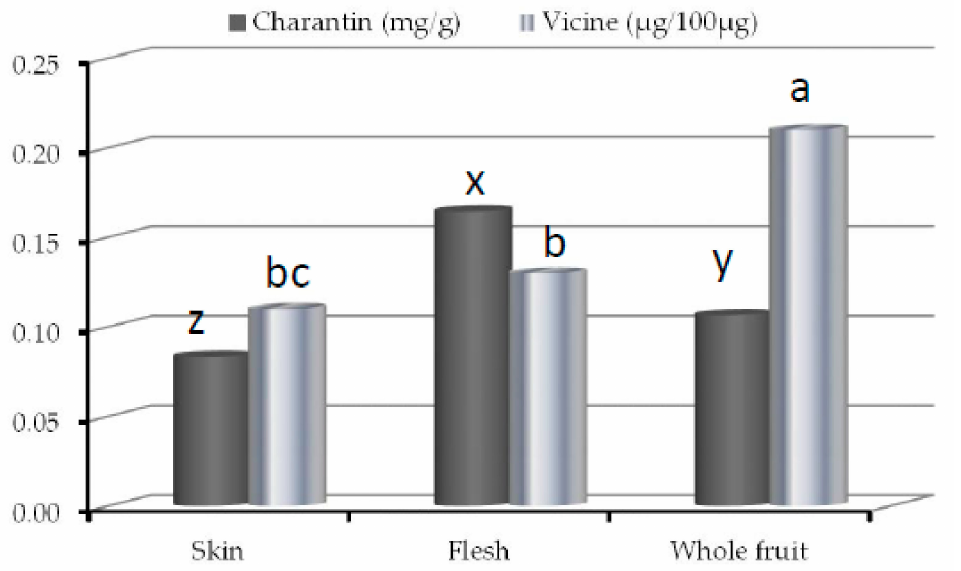
Figure 1. Charantin and vicine contents in skin, flesh and whole fruit of bitter melon. x,y,z indicated significant differences in charantin contents ( p < 0.05); a,b,c indicated significant differences in vicine contents ( p < 0.05).